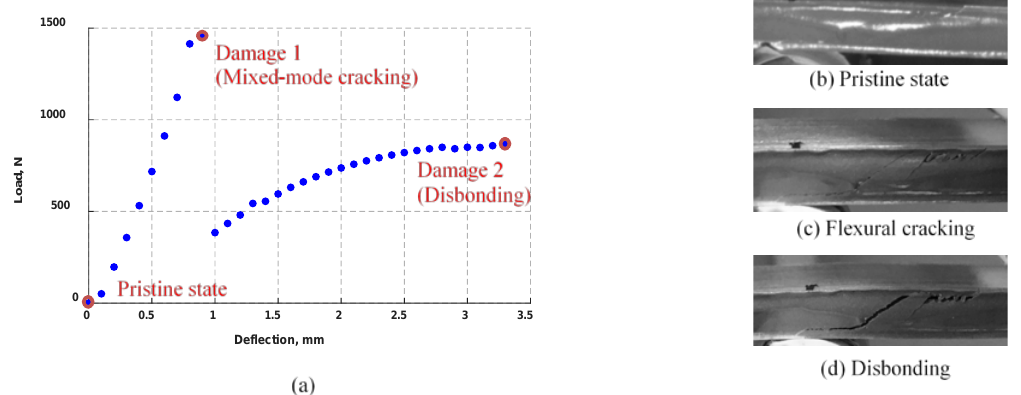
Figure 7. ( a ) Load–deflection response of laminate specimen under three-point bending test at: ( b ) pristine state; ( c ) flexural cracking at 0.9 mm mid-span deflection; and ( d ) disbonding at 3.3 mm mid-span deflection.